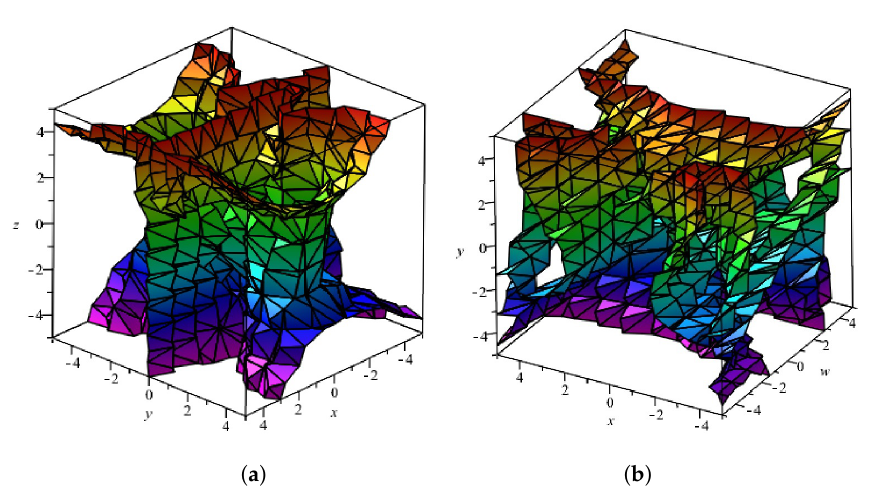
Figure 2. Projection in R 3 of a Henneberg algebraic surface. ( a ): H 4,2 ( x , y , z ) = 0; ( b ): H 4,2 ( x , y , w ) = 0.